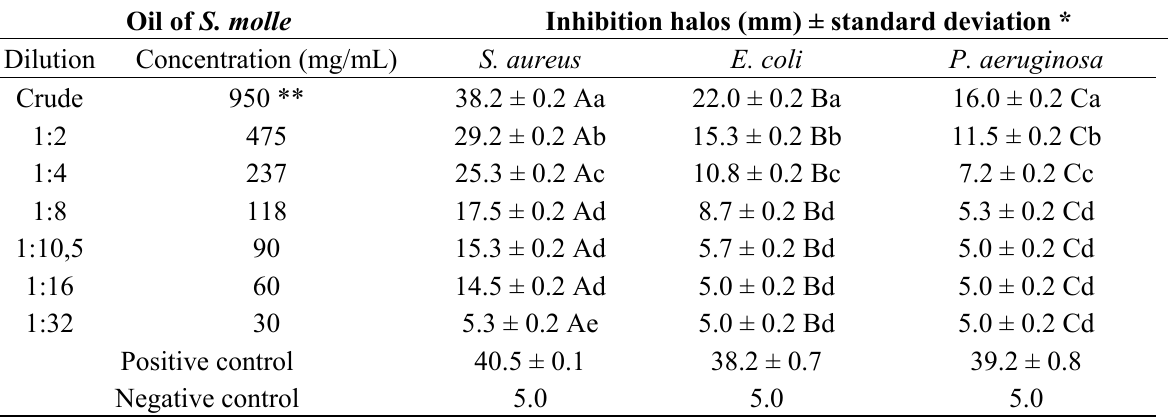
Table 6. Comparison between crude extract and its dilutions. (Tukey’s test at 5% probability). Oil of S.